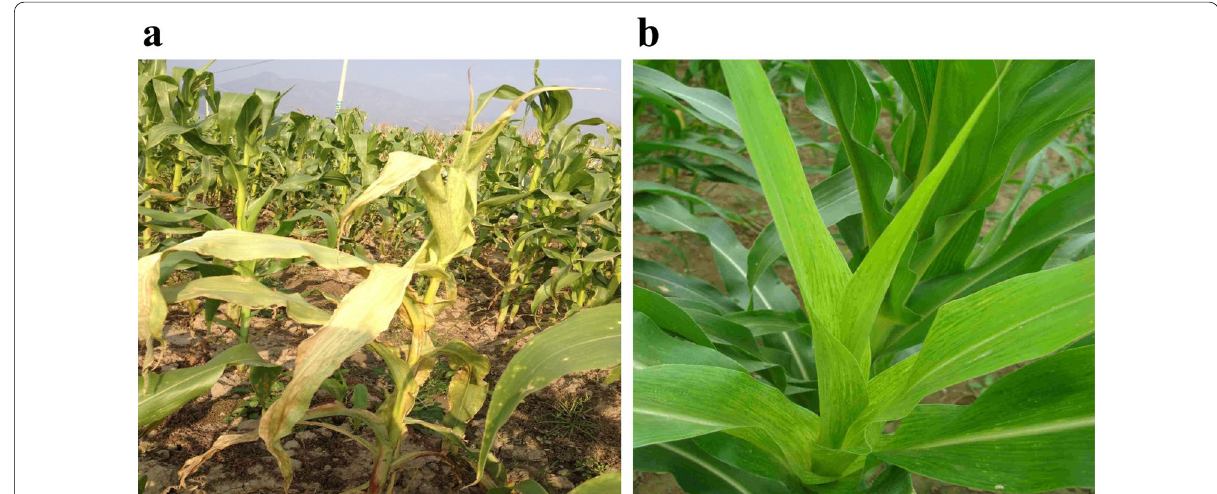
Fig. 1 Maize plants showing lethal necrosis and dwarf mosaic. a Maize plants with lethal necrosis (infected with sugarcane mosaic virus and maize chlorotic mottle virus) in a field in Yunnan Province. b A maize plant infected with sugarcane mosaic virus in